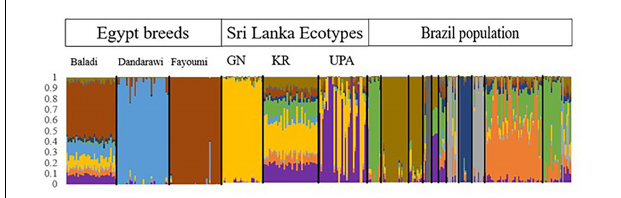
FIGURE 2 | The admixture plot showing mixed ancestry among individuals and populations. The Brazil breeds/ecotypes from left to right; Shamo,